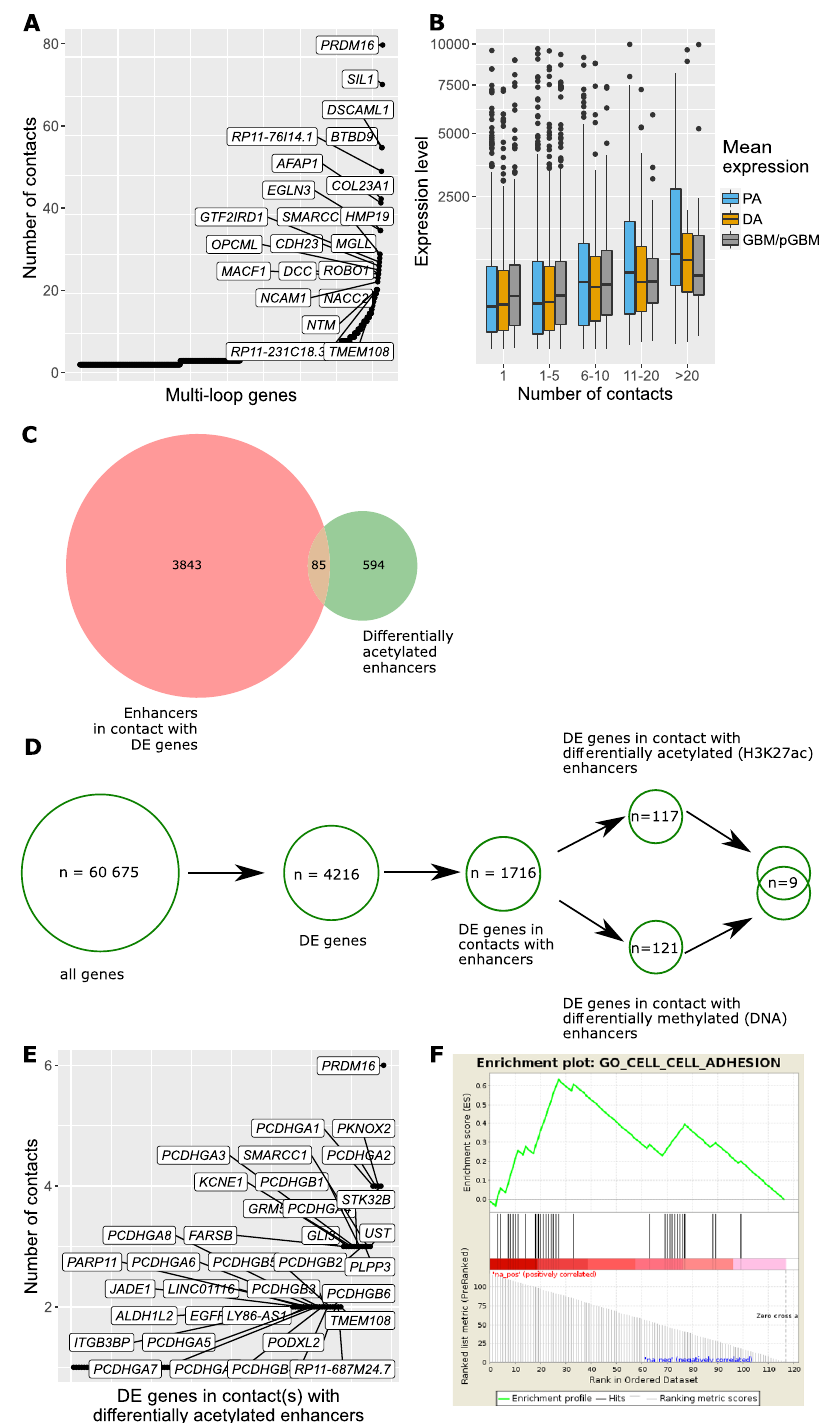
Figure 3. Prediction of gene regulatory networks enriched for multiple predicted contacts with enhancers. ( A ) DEGs from PA vs GBM/pGBM comparison (n = 1041) with predicted multiple contacts with enhancers. ( B ) Higher numbers of contacts with enhancers co-exist with higher expression of DEGs (PA vs GBM/pGBM). ( C ) Enhancers contacting DEGs (PA vs GBM/pGBM) intersect with the differentially acetylated (H3K27ac) (PA vs GBM/pGBM) enhancers. ( D ) Workflow for obtaining DEGs potentially regulated by the differential activity of their contacting enhancers. The obtained enhancer activity might be due to differential H3K27ac and/or DNA methylation marks. Numbers are given for the comparison of PA vs GBM/pGBM. ( E ) DEGs (PA vs GBM/ pGBM) contacting the differentially active enhancers (differential H3K27ac marks between PA vs GBM/pGBM). ( F ) The most enriched gene set from GSEA performed on DEGs having at least one contact with differentially acetylated enhancers between PA vs GBM/pGBM glioma